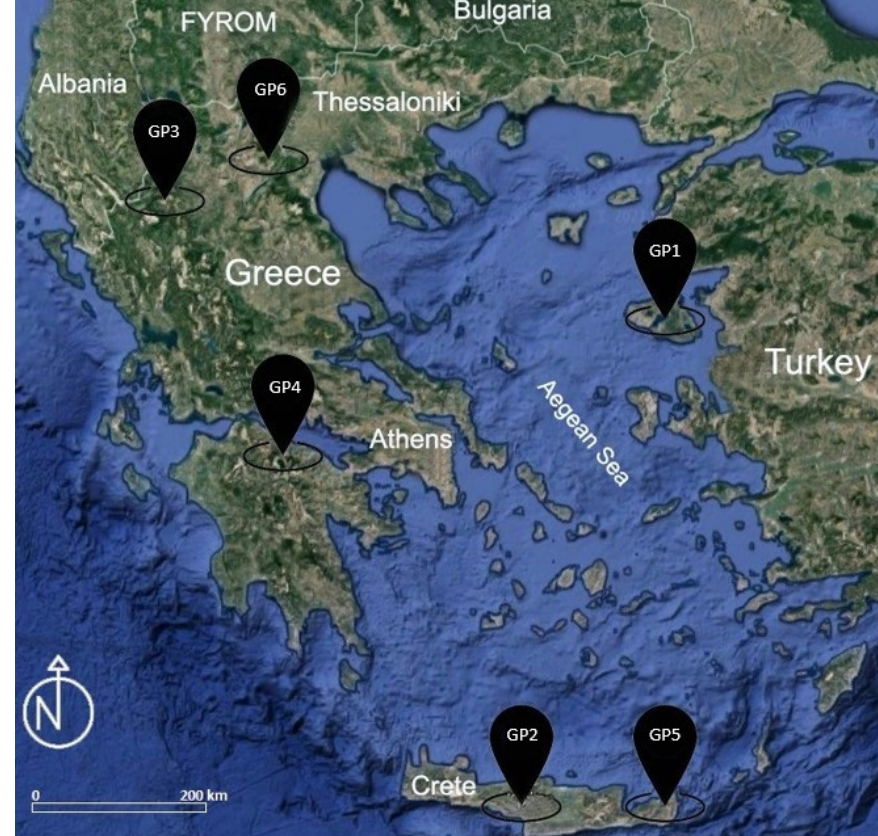
Figure 7. Satellite photo of Greece, indicating the location of Geoparks: GP1—Lesvos, GP2—Psiloritis, GP3—Chelmos–Vouraikos, GP4—Vikos–Aoos, GP5—Sitia and GP6—Grevena–Kozani.